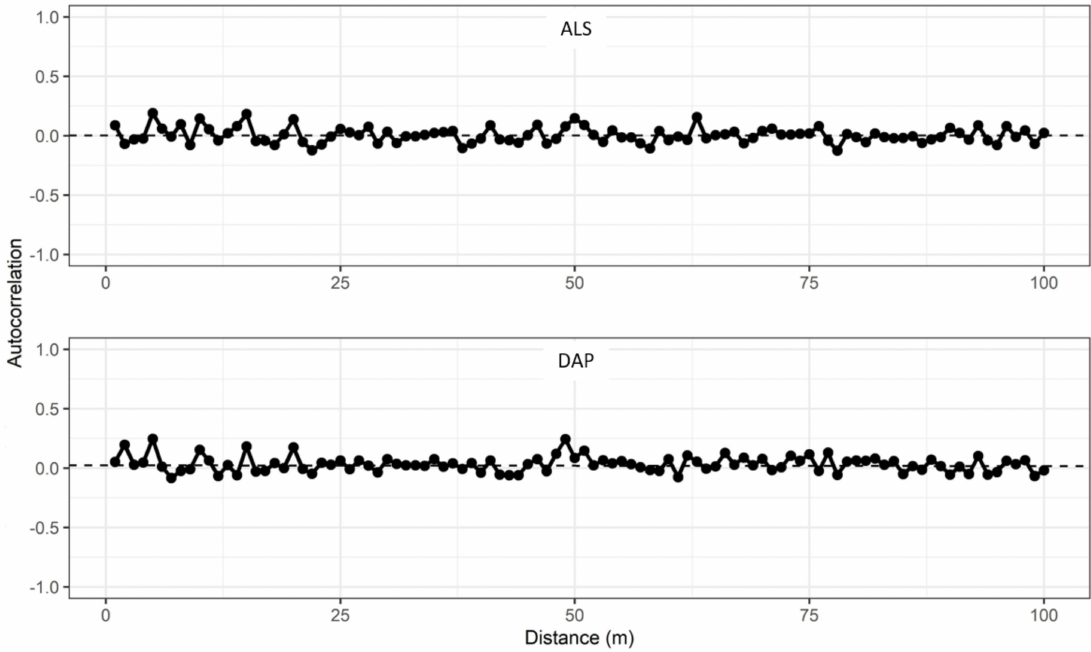
Figure 7. Autocorrelation of observed residuals in models for vegetation height (Equation (5)) based on the ALS ( top ) and DAP ( bottom ) datasets across the entire study area (solid lines) and predicted autocorrelation (dashed lines) according to models in Equation